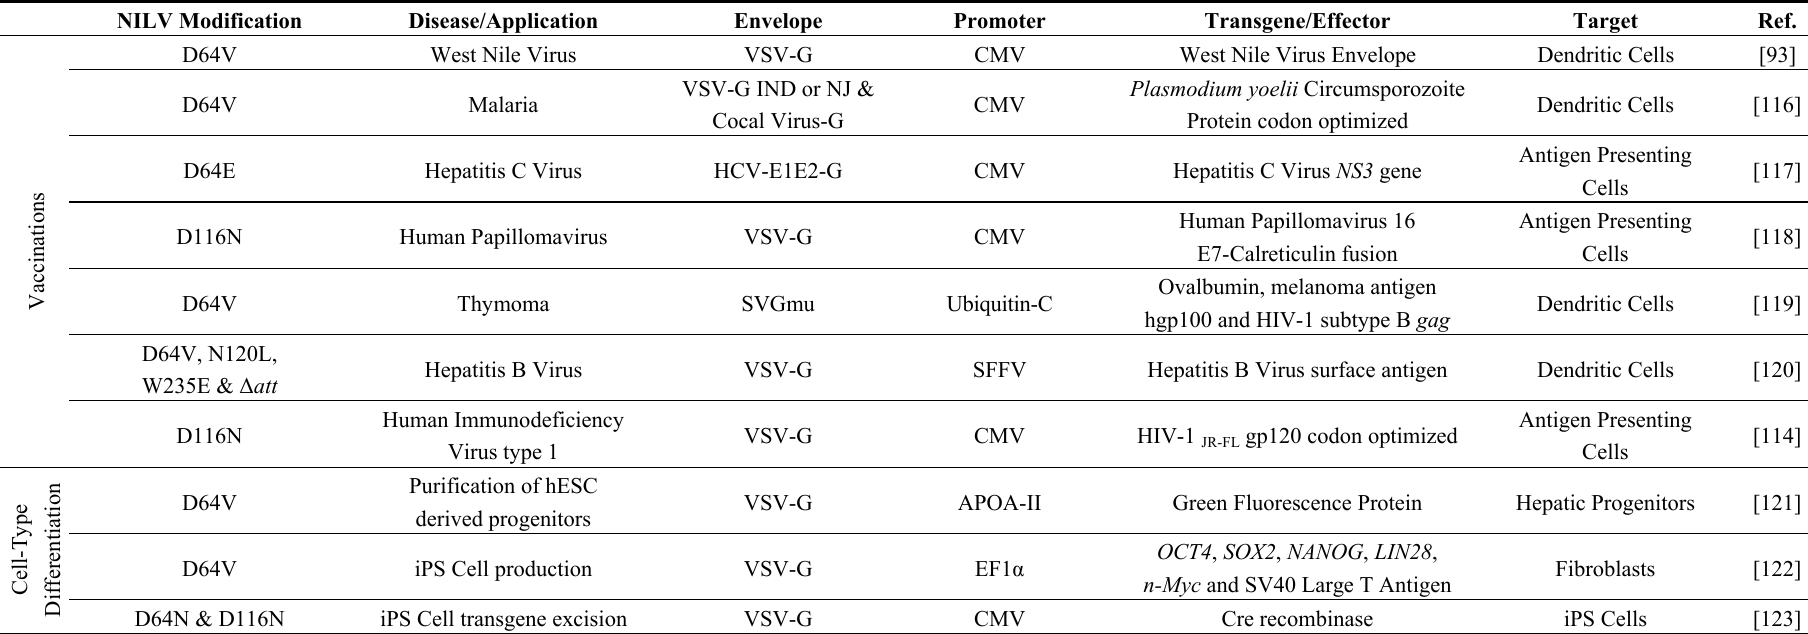
Table 1. Summary of elements included in non-integrating lentiviral vectors (NILV) design. The far right column categorizes the applications depending on the intended purpose. The column of NILV Modifications provides the integrase mutations or Δ att (LTR integrase attachment site mutation) used to inhibit integration. Other components of the vector systems are provided in subsequent columns. Abbreviations: iPS, induced pluripotent stem (cell); VSV-G, Vesicular Stomatitis Virus glycoprotein (IND and NJ serotypes if specified); HCV-E1E2-G,